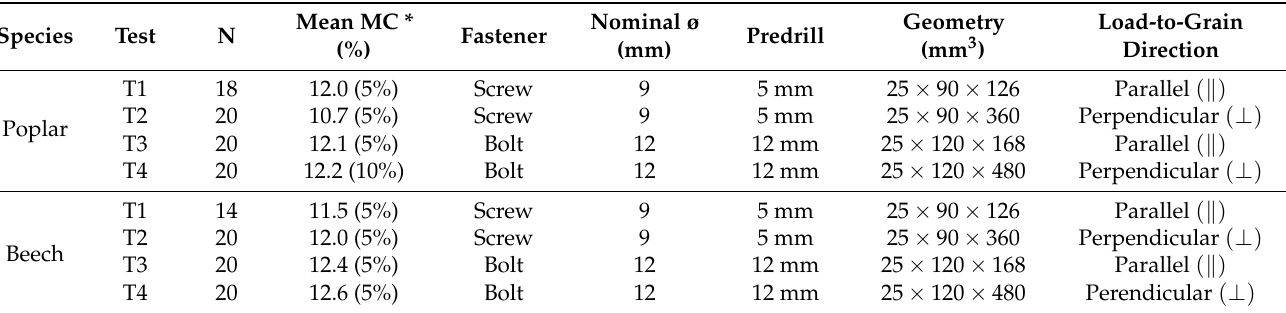
Table 1. Test types per species (poplar and beech).